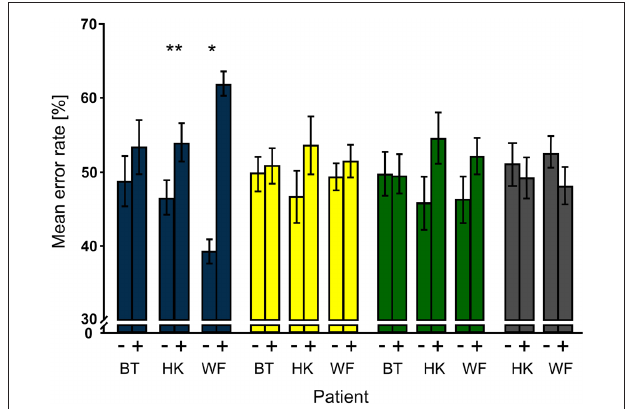
Figure 4 | Trial type-specific effects of distractors. For each patient and distractor condition, mean percentages of false responses on trials without ( − ) and with ( + ) distractors were compared; note that their sum is normalized to 100%. Significant effects were obtained only for bf-hi distractors (blue). Both HK and WF also had higher mean error rates for trials with than trials without low-contrast distractors that were presented to the sighted field (green), but the effects did not survive correction for multiple comparisons. Notation as in Figure 3 .